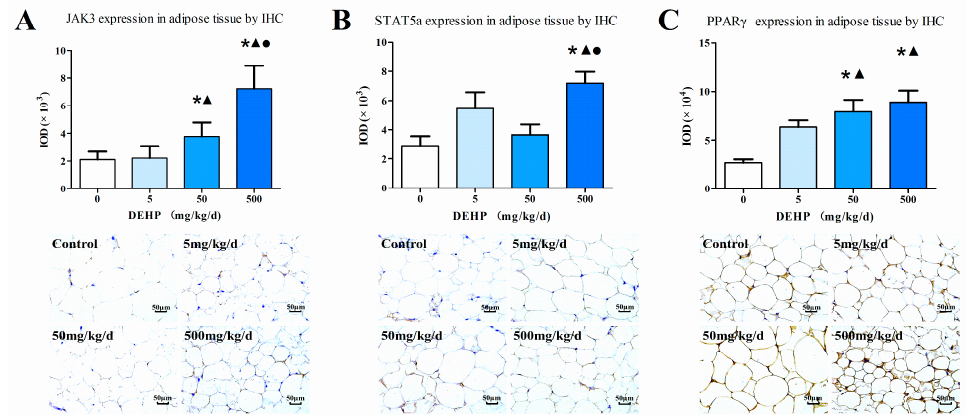
Figure 6. Immunohistochemical determination of proteins in the adipose tissue ( n = 20 animals/each group): ( A ) Immunohistochemical staining of JAK3 expression in the adipose tissue (400×); ( B ) Immunohistochemical staining of STAT5a expression in the adipose tissue (400×); ( C ) Immunohistochemical staining of PPAR γ expression in the adipose tissue (400×); Brown staining indicates areas of positive protein expression. Results were expressed as the mean ± SE ( n = 20 animals/treatment group). ● Statistically signi fi cant di ff erence compared with 50 mg·kg − 1 ·d − 1 ( p < 0.05); ▲ Statistically significant difference compared with 5 mg·kg − 1 ·d − 1 ( p < 0.05); * Statistically significant difference compared with control ( p < 0.05).